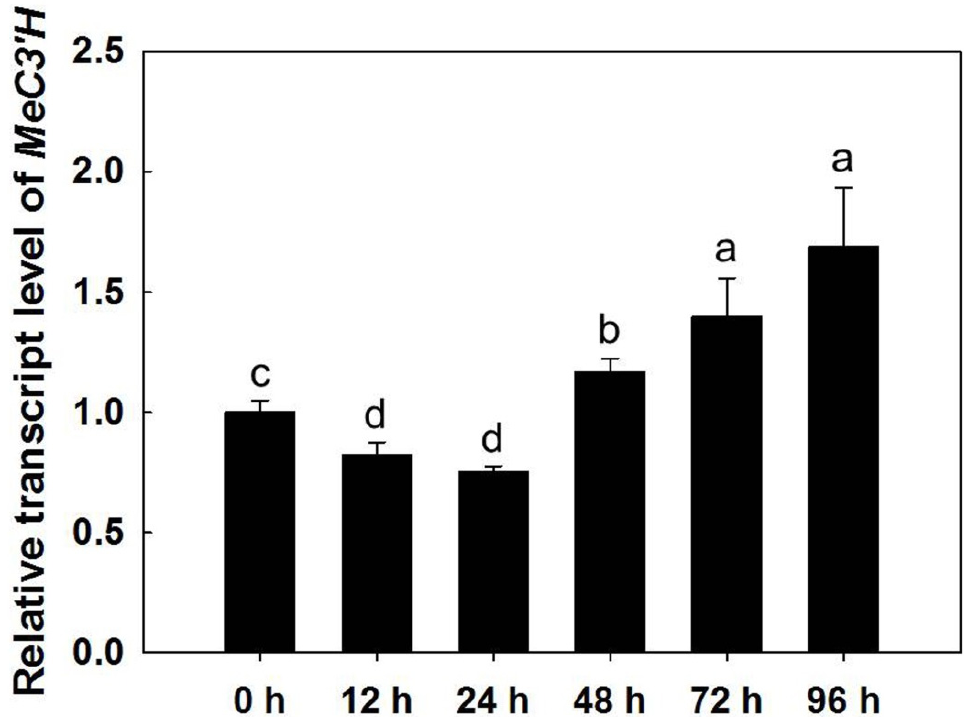
Figure 2. Expression of MeC3 ′ H in storage roots of wild type at different times during the PPD process. Values labeled with different letters (a, b, c and d) at the different time points are significantly different according to Duncan’s multiple comparison tests at p < 0.05. The storage roots of plants grown for 5 months were collected to detect the expression of MeC3 ′ H .